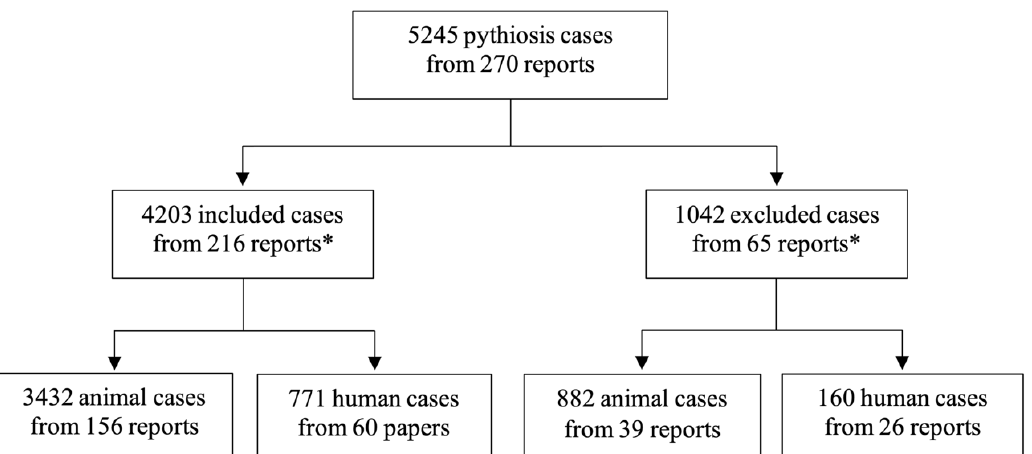
Figure 1. The number of included and excluded pythiosis cases from 270 reports published from 1980–2021. Clinical information of 1042 patients from 65 reports is excluded from the study due to considerably duplicated or repeated cases reported in other publications or lacking information on animal species. Eleven reports (as indicated by the asterisks) contain both included ( n = 1830) and excluded ( n = 133) cases of pythiosis. Four thousand two hundred and three pythiosis cases from 216 reports were recruited for epidemiological analyses.